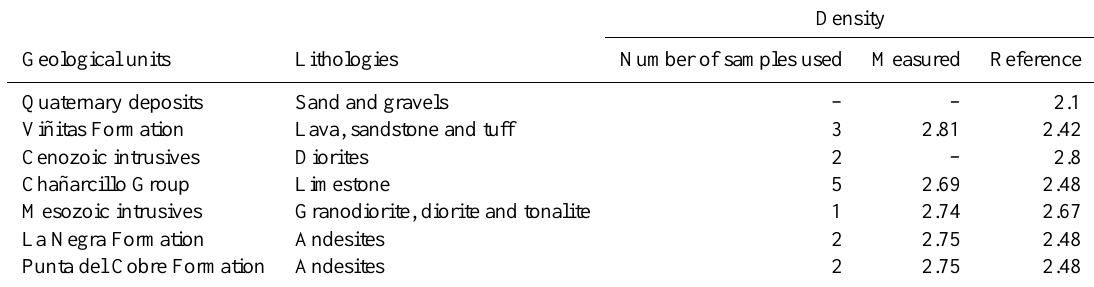
Figure 7. (a) Synextensional faults affecting the rocks of the Abundancia Formation (see location in Fig. 3); (b) details of the growth strata observed in the basal successions of the Chañarcillo Group (see location in Fig. 3); (c) aspect of the listric geometry recognized for the synextensional faults in the Chañarcillo Group (see location in Fig. 3). Table 1. Sampling and density